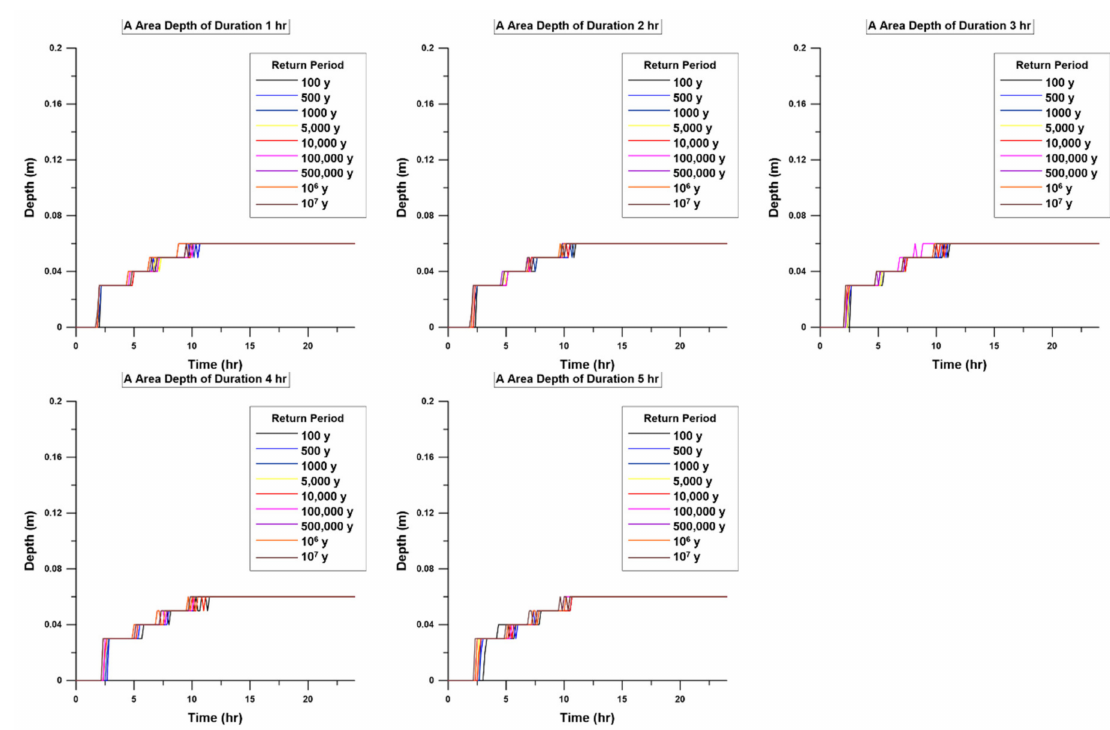
Figure 13. 2D flood depths from the 2D internal analysis results (Area A, NPP 2).